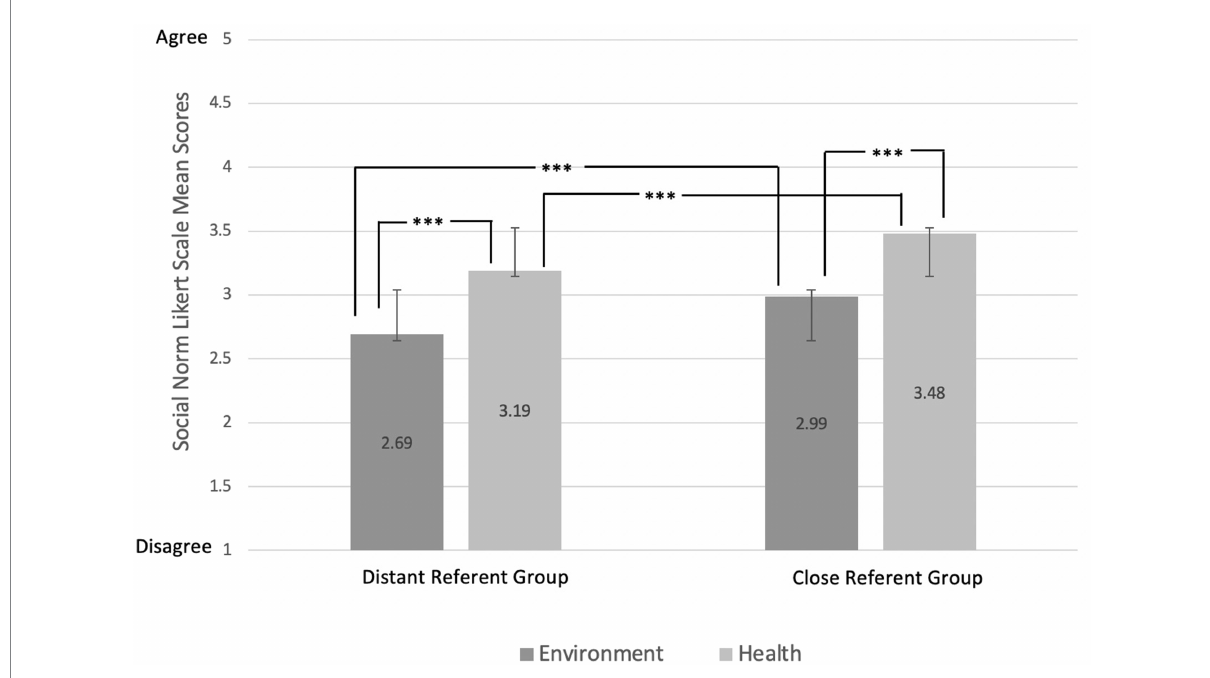
FIGURE 2 Means of responses to social norm items* (1 = strongly disagree – 5 = strongly agree) (*** = p < 0.001). *“ Most people in the UK will try to choose the food items that are better for the environment .” (environment, distant). “ People who I share my meals with will try to choose the food items that are better for the environment .” (environment, close). “ Most people in the UK will try to choose the food items that are better for their health .” (health, distant). “ People who I share my meals with will try to choose the food items that are better for their health .” (health,